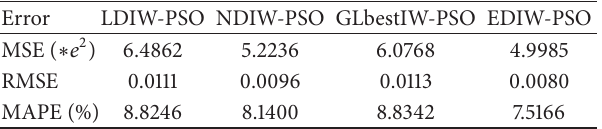
Table 5: The values of MSE, RMSE, and MAPE (%) of predictied ouput by four models for the daily air quality index (AQI) of Xi’an.